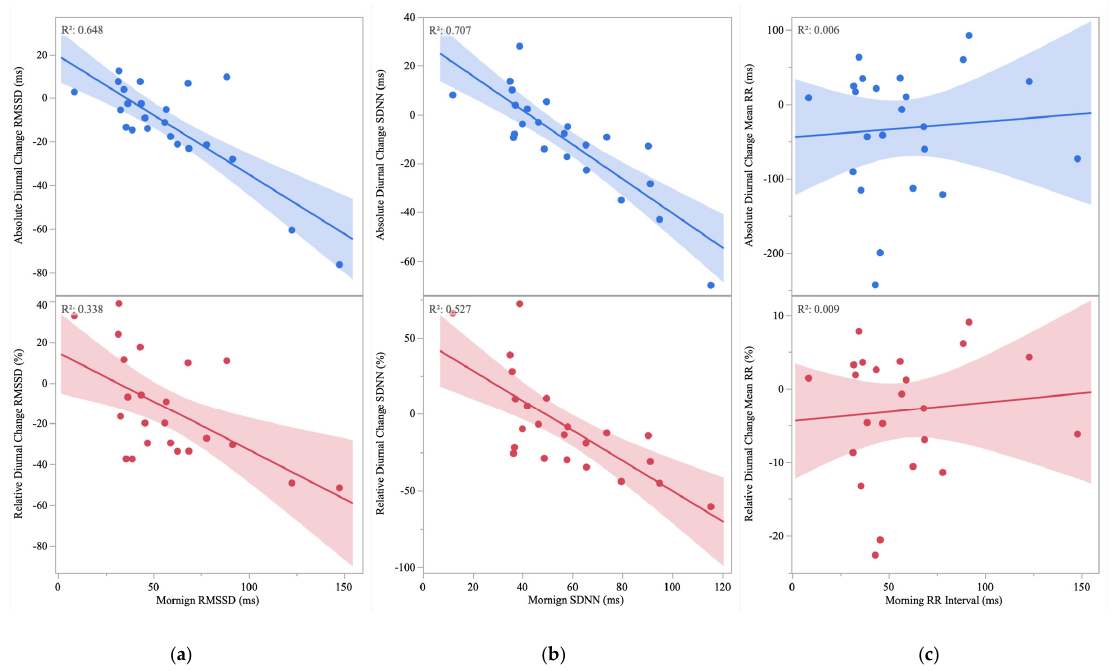
Figure 1. ( a ) Association between absolute and relative change in root mean square of successive differences in normal RR intervals (RMSSD) and morning RMSSD. ( b ) Associations between absolute and relative change in standard deviation of normal–to–normal RR intervals (SDNN) and morning SDNN. ( c ) Associations between absolute and relative change in mean R–R (mean RR) and morning mean RR.